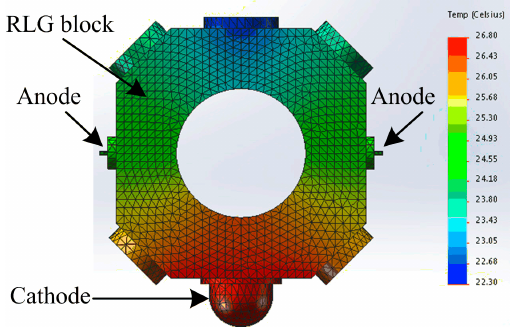
Figure 1. Thermal image of working RLG.